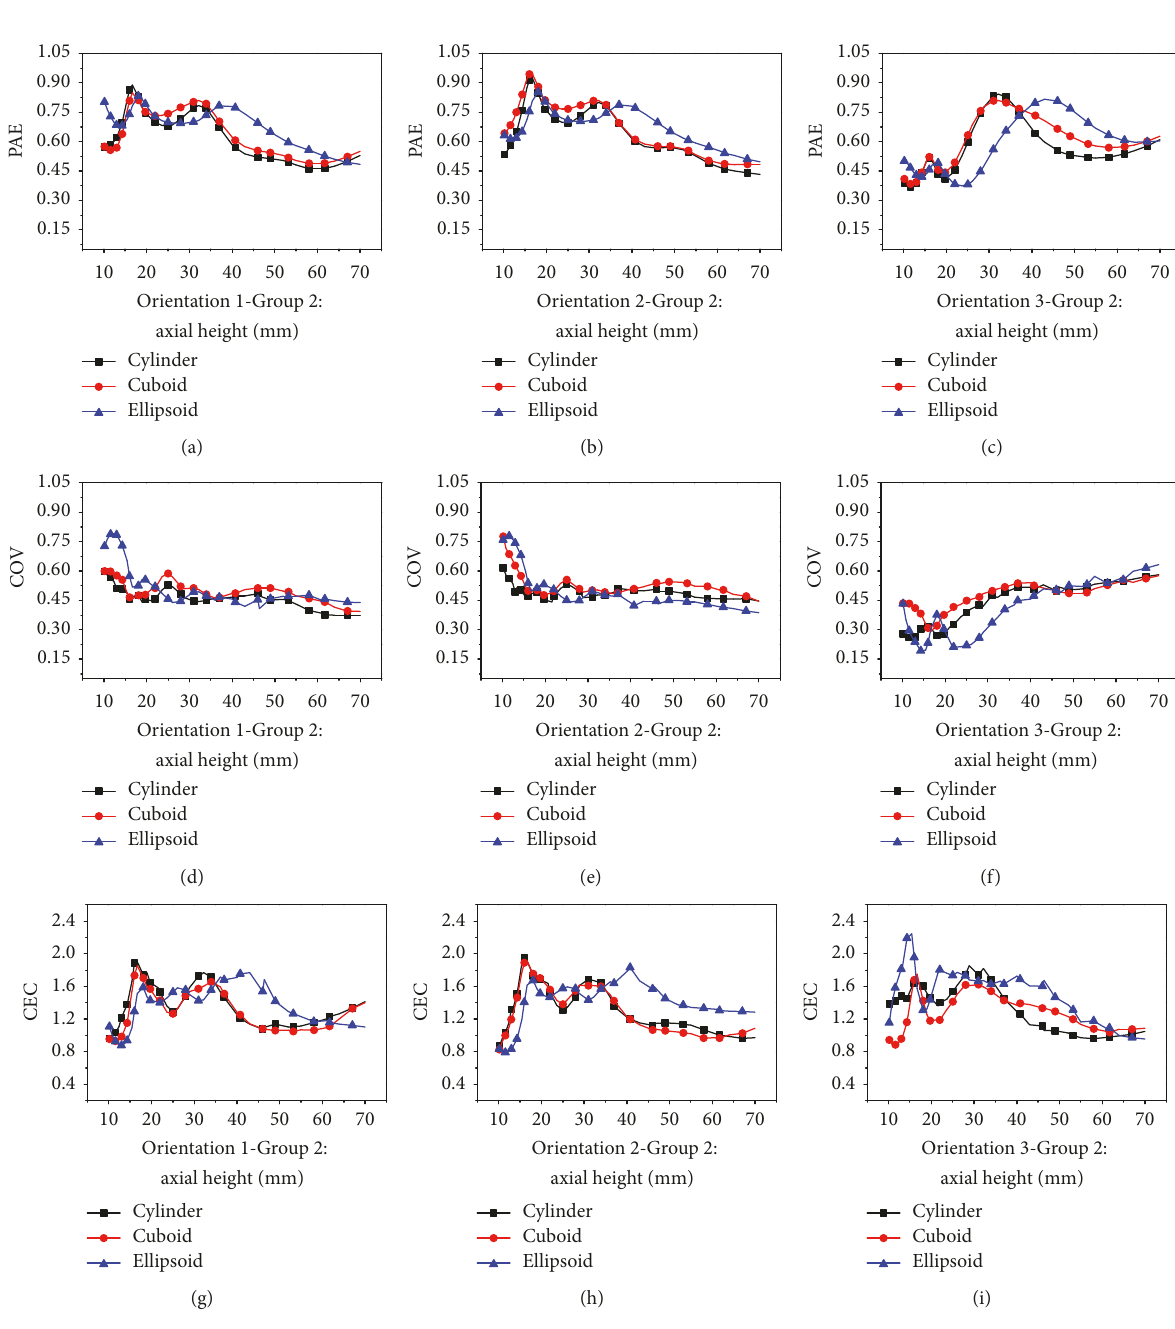
Figure 21: Different samples in the same orientations, Group